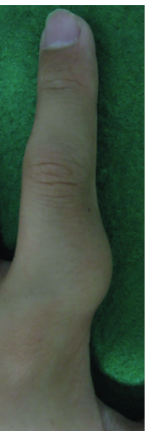
Figure 1: Photograph shows a slightly protuberant, subcutaneous mass in the radial aspect of the proximal phalanx of the left index finger.